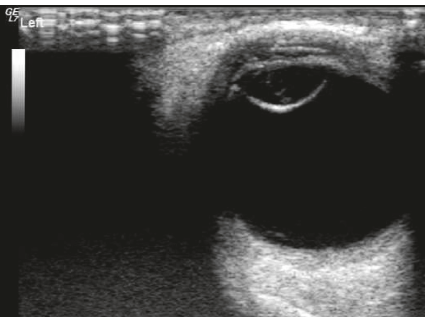
Figure 4: False-negative image of PC by 14MHz +THI. The lens is dilated and regular in shape, with a cord-like medium echo and smooth, continuous PC